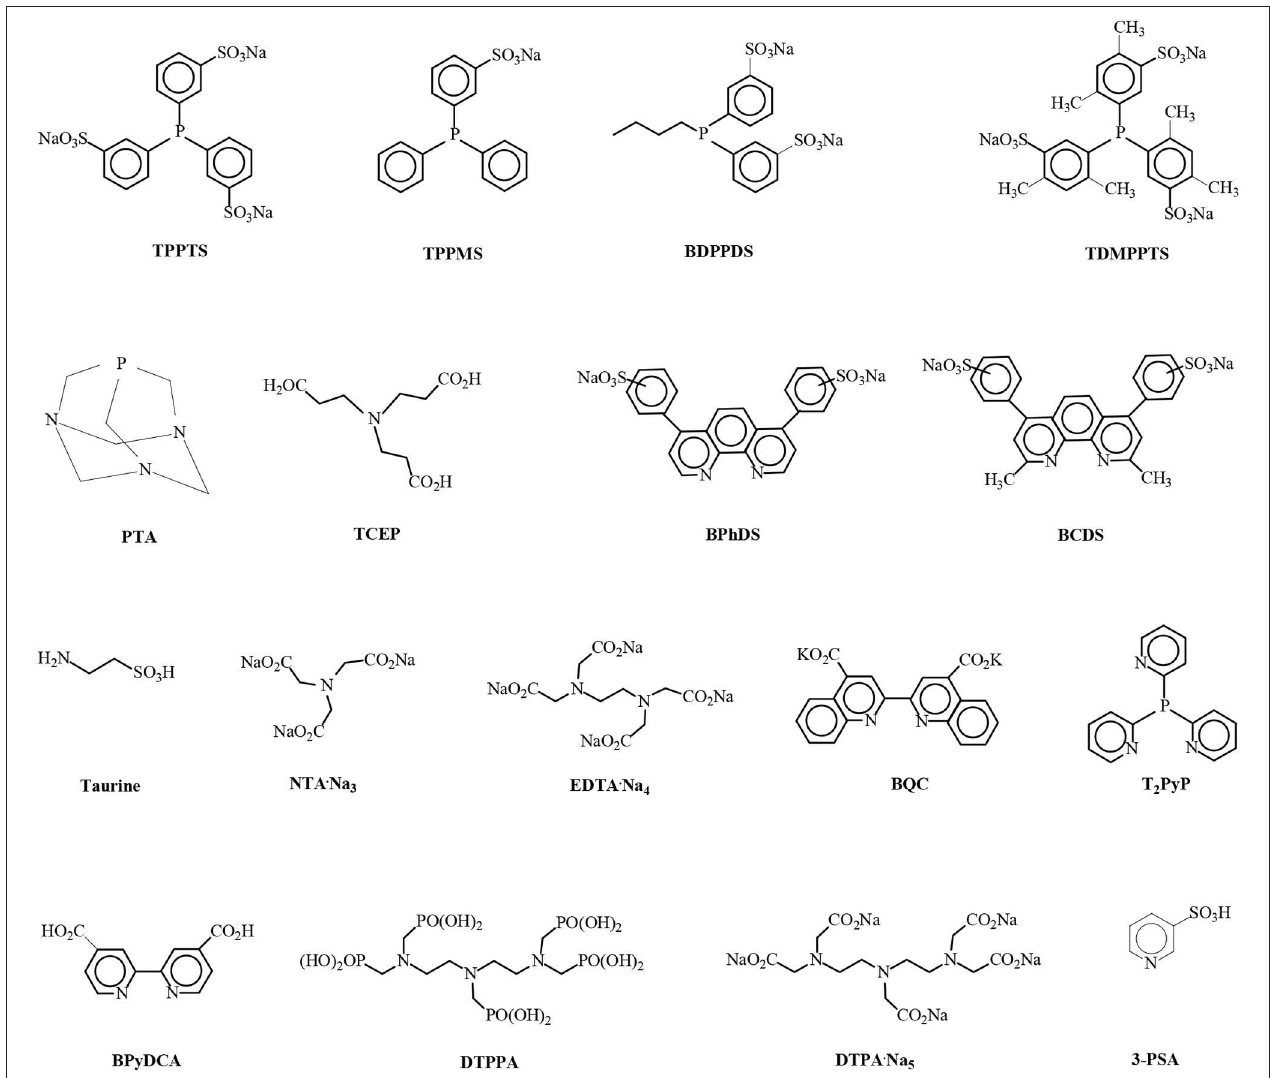
FIGURE 8 | Structures of the water-soluble ligands triphenylphosphinetrisulfonic acid trisodium salt (TPPTS), triphenylphosphinemonosulfonic acid monosodium salt (TPPMS), n -butyldiphenylphosphinedisulfonic acid disodium salt (BDPPDS), tris(2,4-dimethylphenyl)phosphinetrisulfonic acid trisodium salt (TDMPPTS), 1,3,5-triaza-7-phosphaadamantane (PTA), tris(2-carboxyethyl)phosphine (TCEP), bathophenanthrolinedisulfonic acid disodium salt (BPhDS), bathocuproinedisulfonic acid disodium salt (BCDS), 2-aminoethanesulfonic acid (Taurine), nitrilotriacetic acid trisodium salt (NTA · Na 3 ), ethylenediaminetetraacetic acid tetrasodium salt (EDTA · Na 4 ), 2,2 ′ -biquinoline-4,4 ′ dicarboxylic acid dipotassium salt (BQC), tris(2-pyridyl)phosphine (T 2 PyP), N,N ′ -2,2 ′ -bipyridine-4,4 ′ -dicarboxylic acid (BPyDCA), diethylenetriaminepentakis(methylphosphonic acid) (DTPPA), diethylenetriaminepentaacetic acid pentasodium salt (DTPA · Na 5 ) and 3-pyridinesulfonic acid